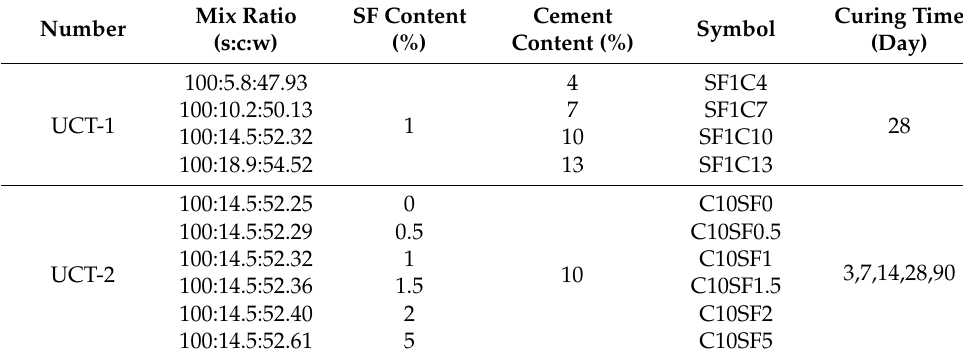
Table 3. The unconfined compressive test (UCT) programs.